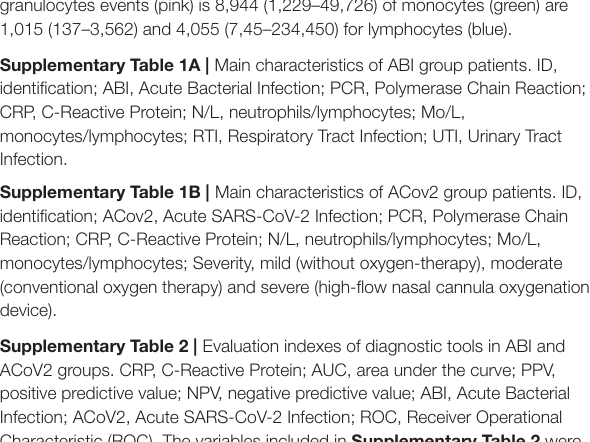
Supplementary Figure 1 | Gating strategies are displayed. The median (range) of granulocytes events (pink) is 8,944 (1,229–49,726) of monocytes (green) are Supplementary Table 1A | Main characteristics of ABI group patients. ID, identification; ABI, Acute Bacterial Infection; PCR, Polymerase Chain Reaction;